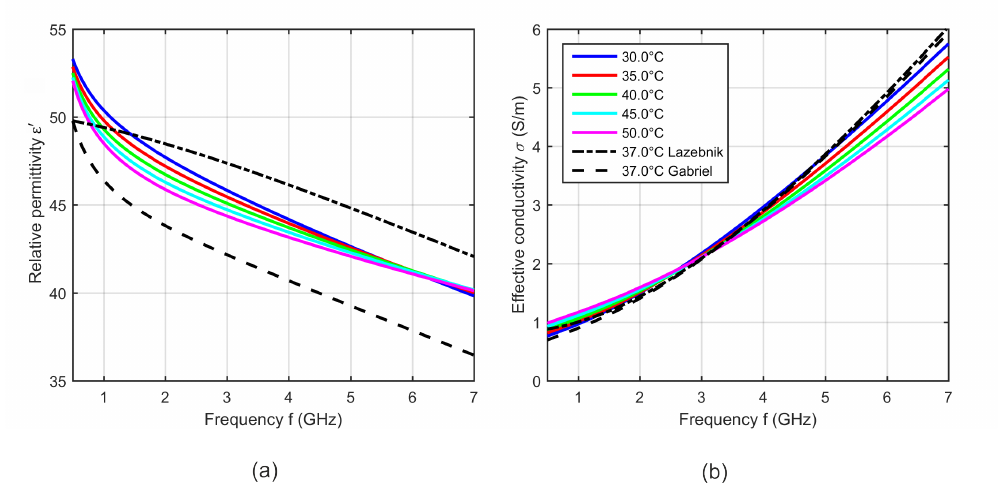
Figure 8. ( a ) Relative permittivity and ( b ) effective conductivity of porcine liver as a function of frequency at five different temperatures determined by the two-pole Cole-Cole model based on the derived temperature dependent Cole-Cole parameters. Black curves show the dielectric properties of liver reported by Lazebnik (bovine) [19] and Gabriel (ovine) [31] at 37 ◦